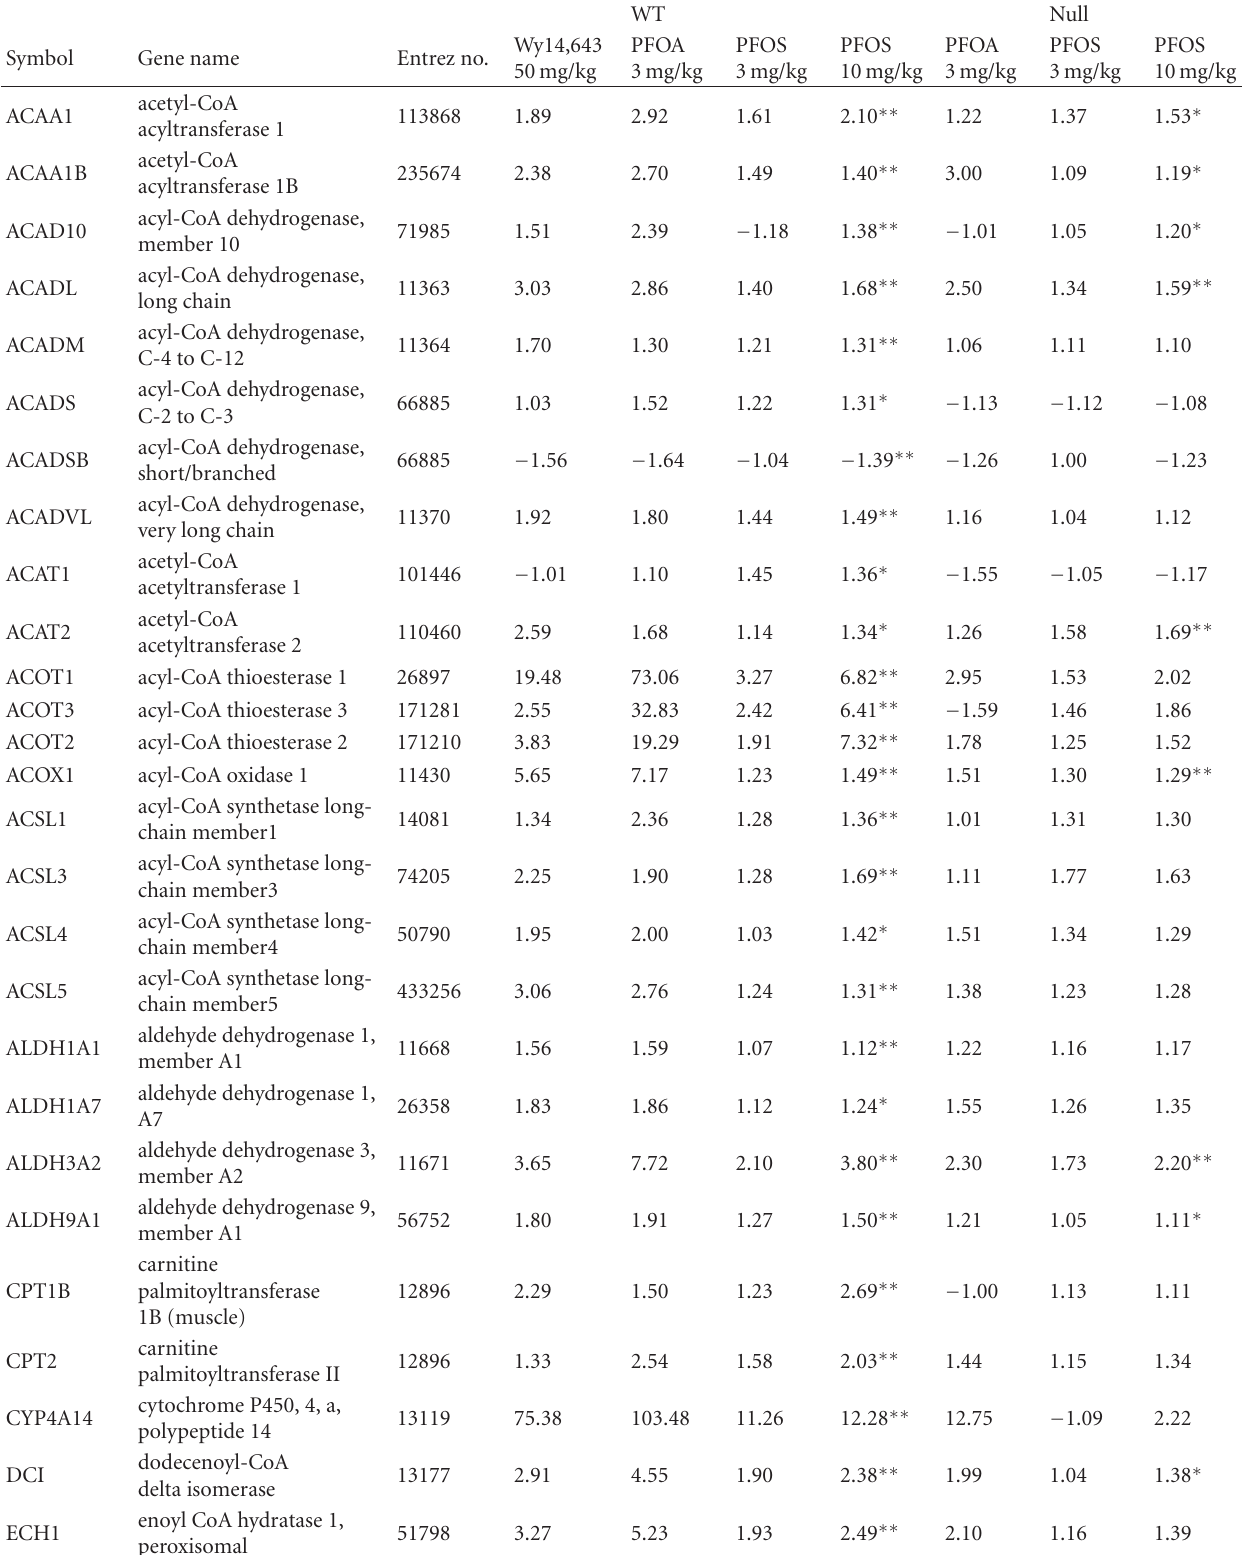
Table 3: Average fold change for genes related to lipid metabolism in wild-type and PPAR α -null male mice following a seven-day exposure to Wy-14,643 1 , PFOA 1 , or